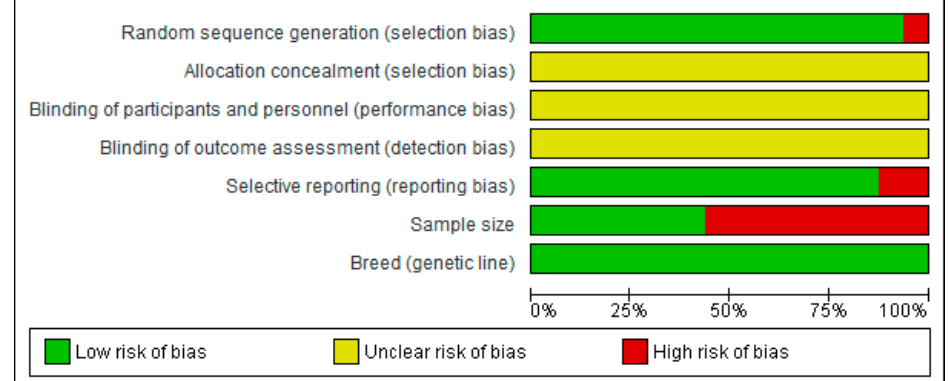
Figure 3. Overall quality assessment summary.